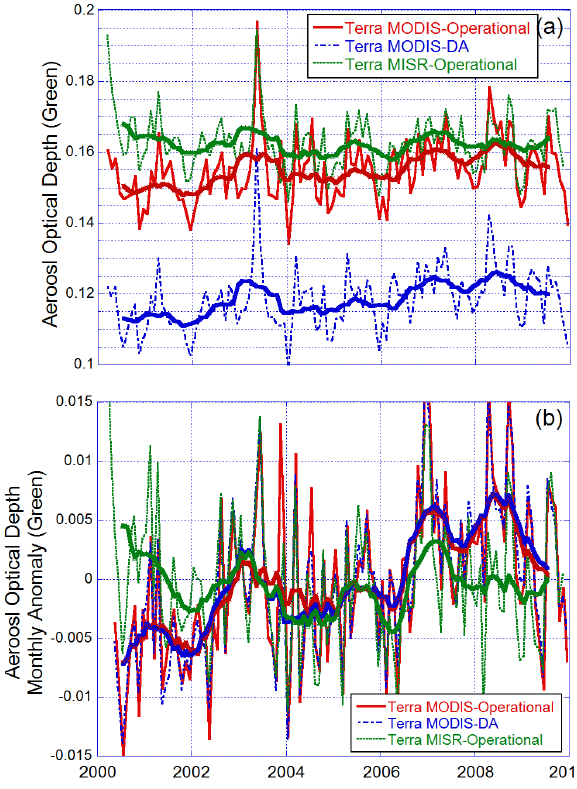
Figure 2 Fig. 2. (a) Ten-year (2000-2009) AOD trend analysis using both the over water collection 5 MODIS aerosol product (operational, red lines), the DA quality level 3 over water Terra MODIS aerosol prod- uct (blue lines), and the version 22 over water Terra MISR aerosol product (green lines). The thin line shows the monthly mean AOD patterns from the three products, and the thick solid lines show the boxcar analysis (window size, ± 5 months) for the monthly mean Terra MODIS (red), Terra-MISR (green), and DA quality MODIS (blue) over water aerosol products. (b). Similar to (a), but using deseasonalized Terra MODIS (red lines), Terra MISR (green lines), and the DA quality MODIS (blue) over water aerosol